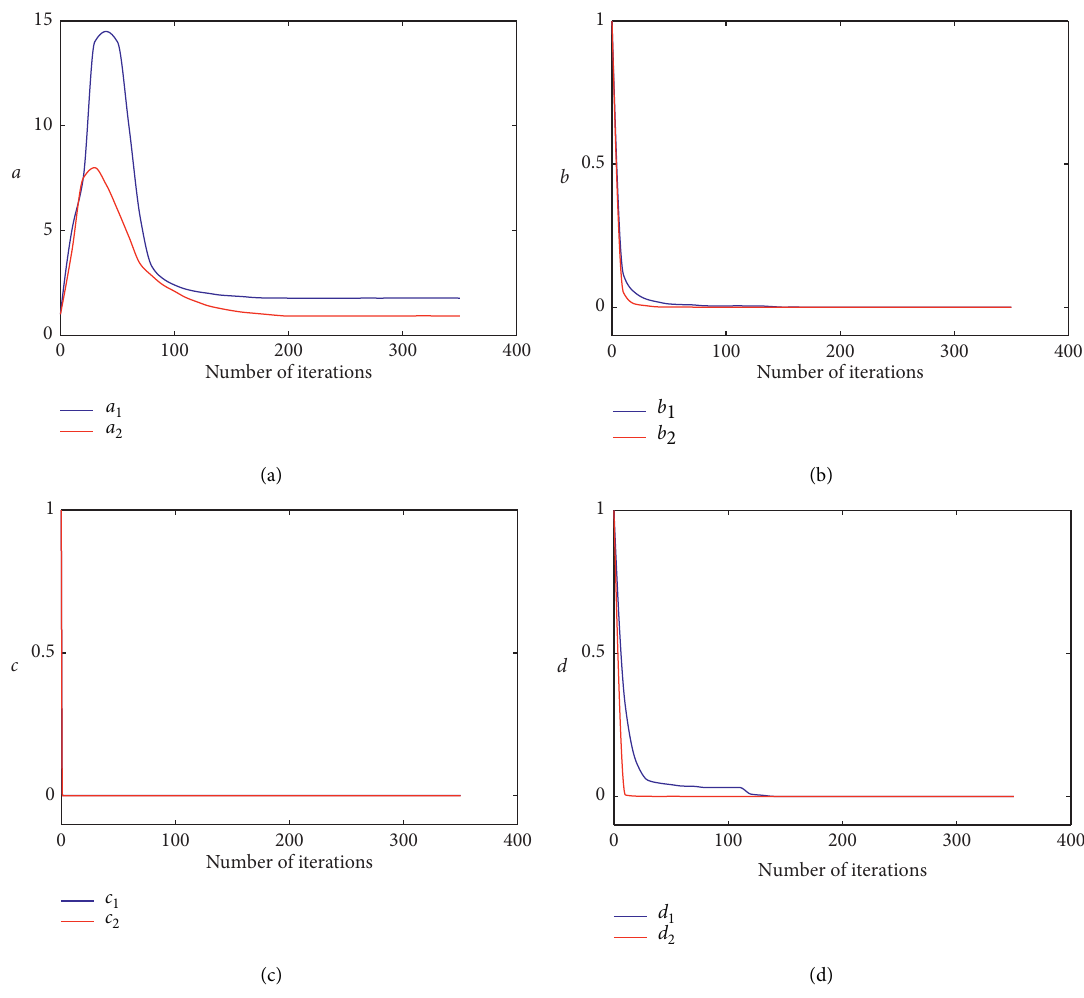
Figure 2: Iterative convergence process of hyperparameter estimation. Table 2: Estimation of hyperparameter in prior distribution.